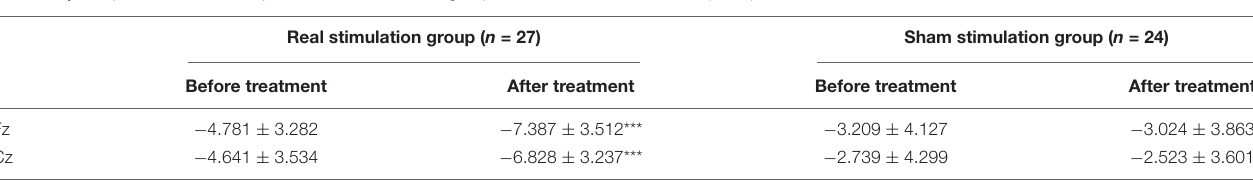
***p < 0.001. MMN, mismatch